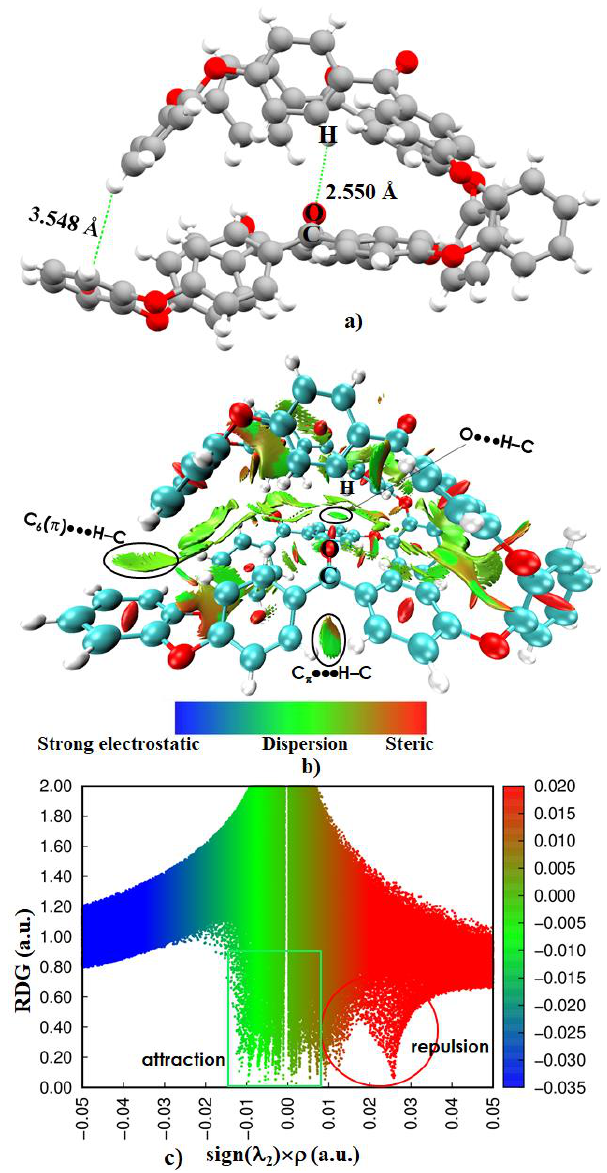
Figure 4. ( a ) The B97-D3 relaxed ball-and-stick model of the o-PEEK oligomer. ( b ) The RDG isosurface plot (0.6 a.u.) and ( c ) the sign( λ 2 ) × ρ vs. RDG plot, showing the importance of intramolecular interactions in driving the structural stability of the homopolymer. Selected intramolecular contact distances are shown in ( a ) and some of these are marked in ( b ). Labeling of atom type is shown both in ( a ) and ( b ). The blue and green colors in ( b ) indicate electrostatically and dispersion dominant interactions, respectively. On the other hand, red indicates repulsion.